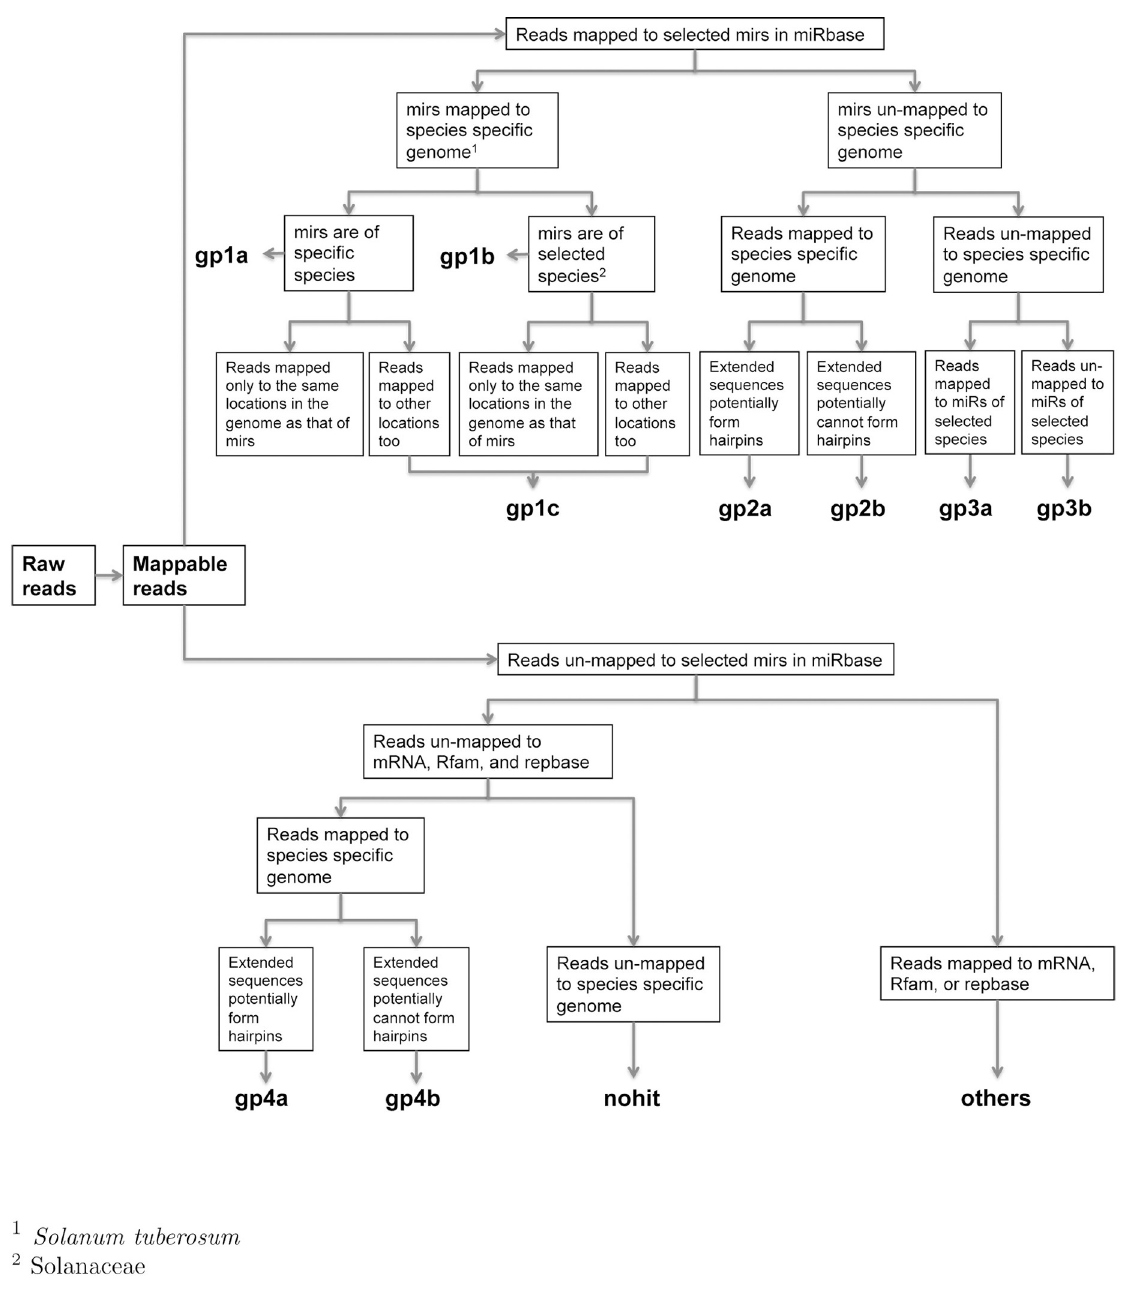
Fig 1. Flow chart of data